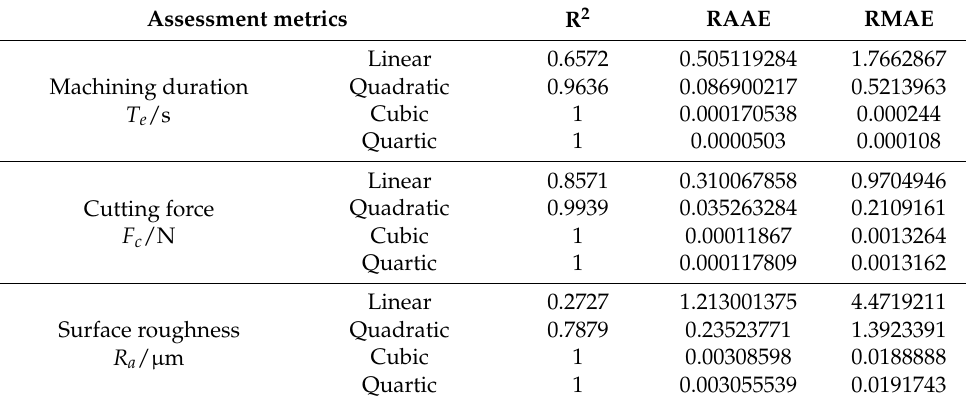
Table 5. Accuracy assessment for the response surface